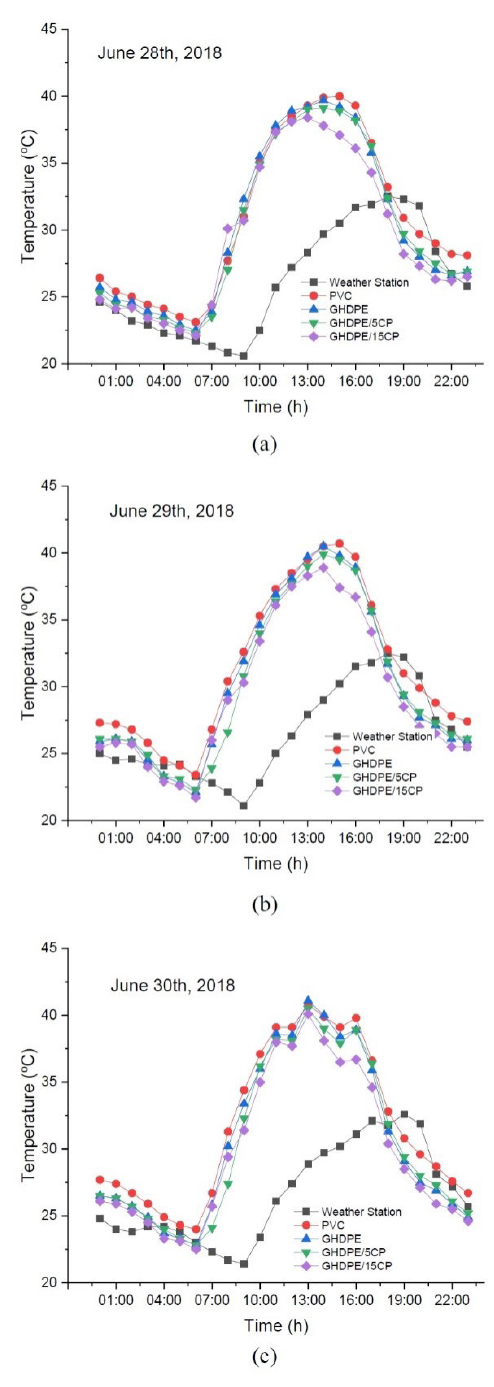
Figure 7. Temperature measured at different times in both insided the prototypes and outside by the weather station: (a) June 28th; (b) June 29 th ; (c) June 30 th